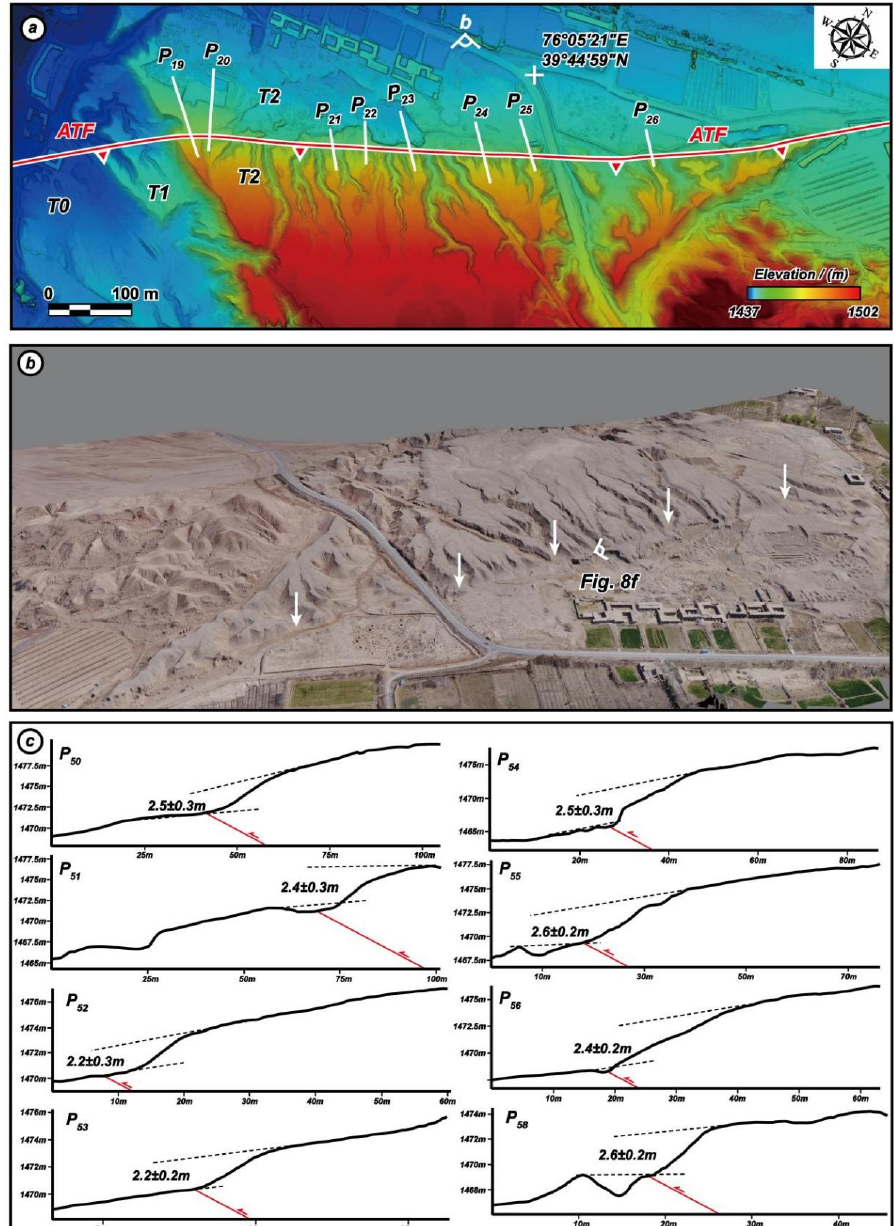
Figure 7. The tectono-geomorphic features in the southern Aqike village (site 4 as shown in Figure 3b) ( a ) The DSM data generated by the UAV-based photogrammetry showing linear fault scarp developed on the T2 surface; ( b ) the UAV DOM-based 3D perspective image showing the geomorphic details of fault scarp along the ATF (white arrows), the view direction towards the fault scarp shown in Figure 7a. ( c ) The measured throws along the fault, and the locations of the profile are shown in Figure 7a.